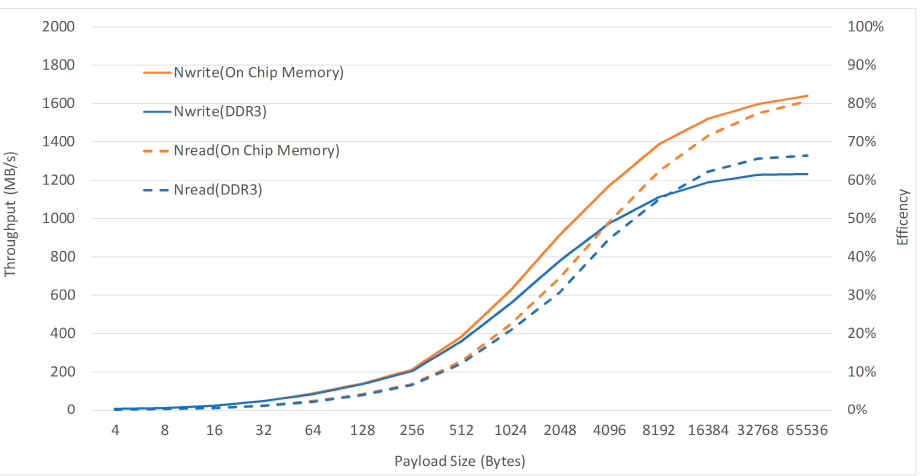
Figure 5. Data throughput experiment results in our Micro Telecom Computing Architecture (MTCA)-based Serial Rapid IO (SRIO) testbed.